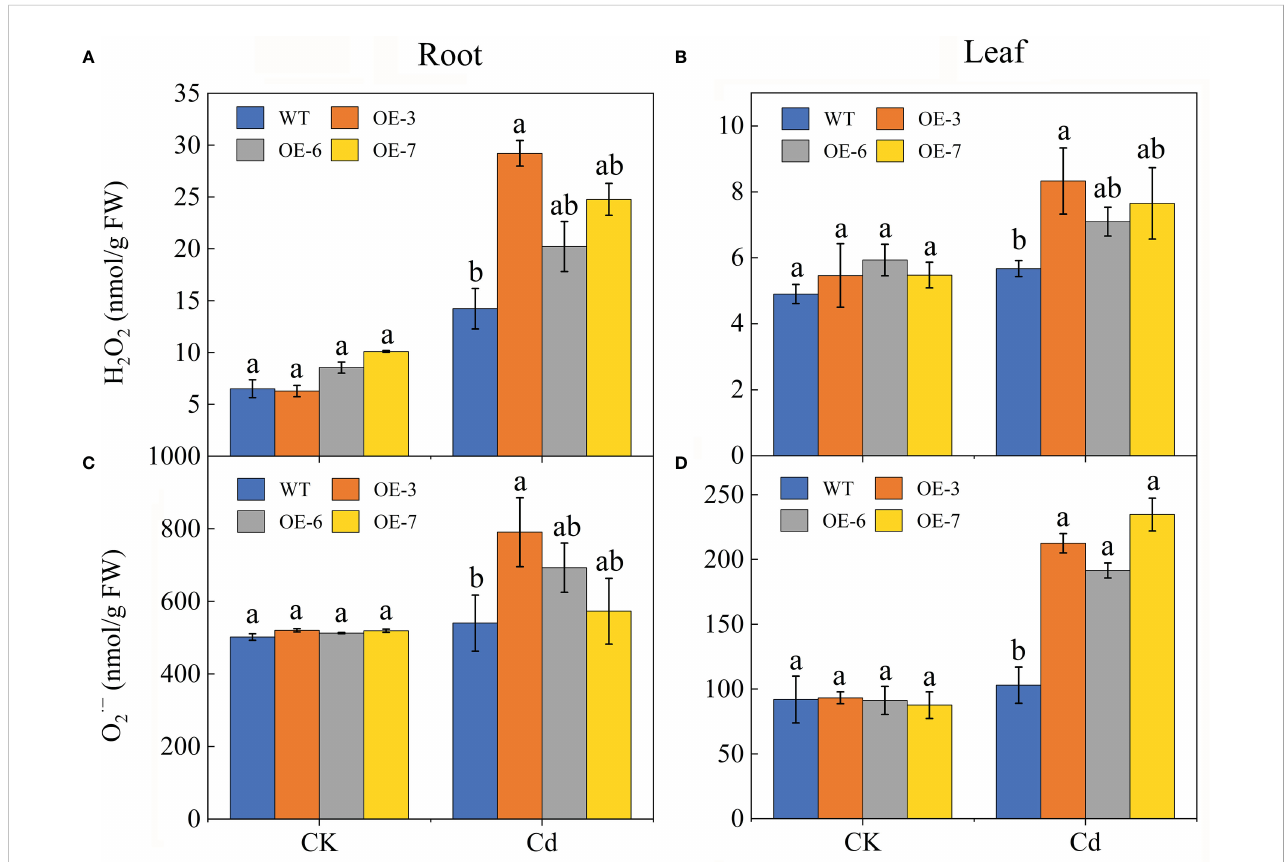
FIGURE 5 Effect of Cd stress on the ROS contents of the WT and SpCTP3 -overexpressing transgenic poplar roots and leaves. (A) Root H 2 O 2 concentrations. (B) Leaf H 2 O 2 concentrations. (C) Root O · − 2 concentrations. (D) Leaf O · − 2 concentrations. Data are presented as the mean ± SD of three independent replicates. Different letters above bars indicate signi fi cant differences among treatments ( p <